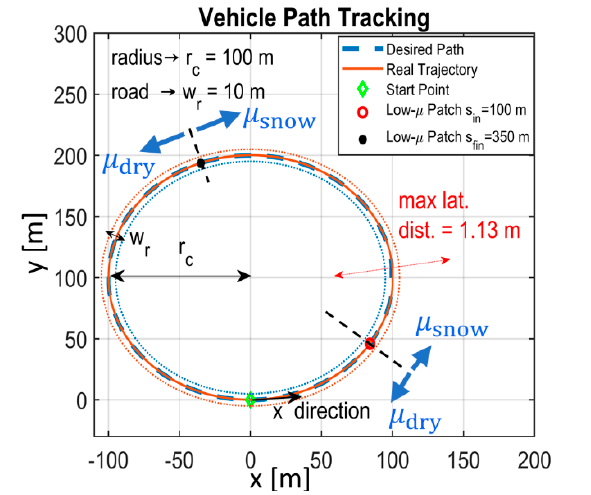
Figure 19. SV Equalization: speed tracking.